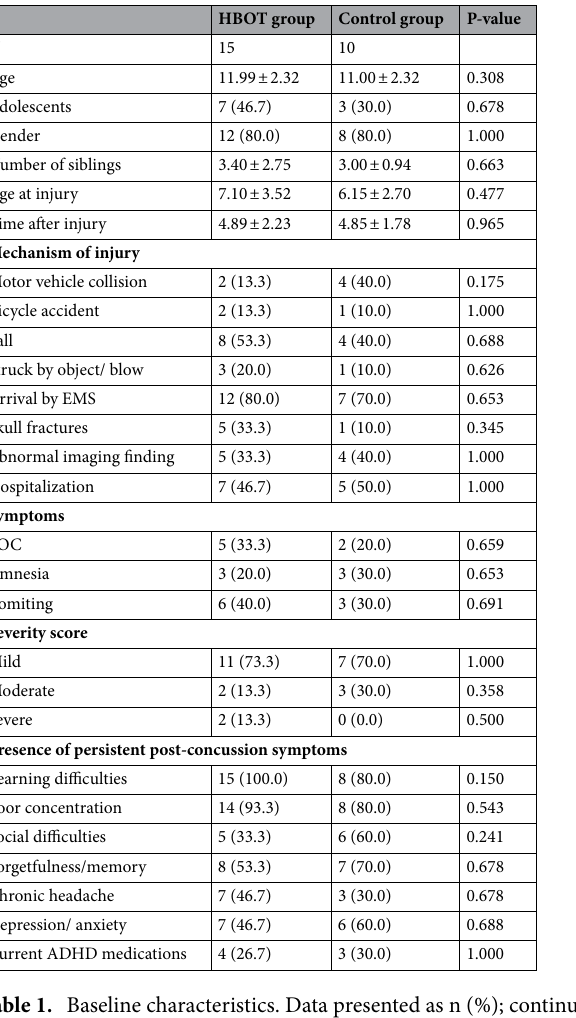
Table 1. Baseline characteristics. Data presented as n (%); continuous data, mean ±